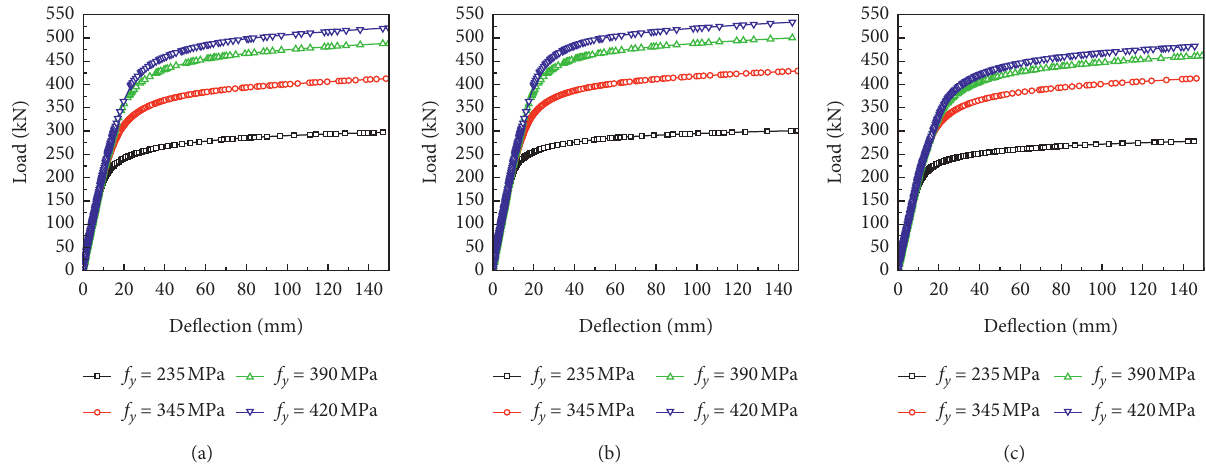
Figure 16: Load-deflection curves of the TGCB models with different yield strength of steel girder: (a) outer girder G1 in curved TGCB models, (b) inner girder G2 in curved TGCB models, and (c) straight TGCB